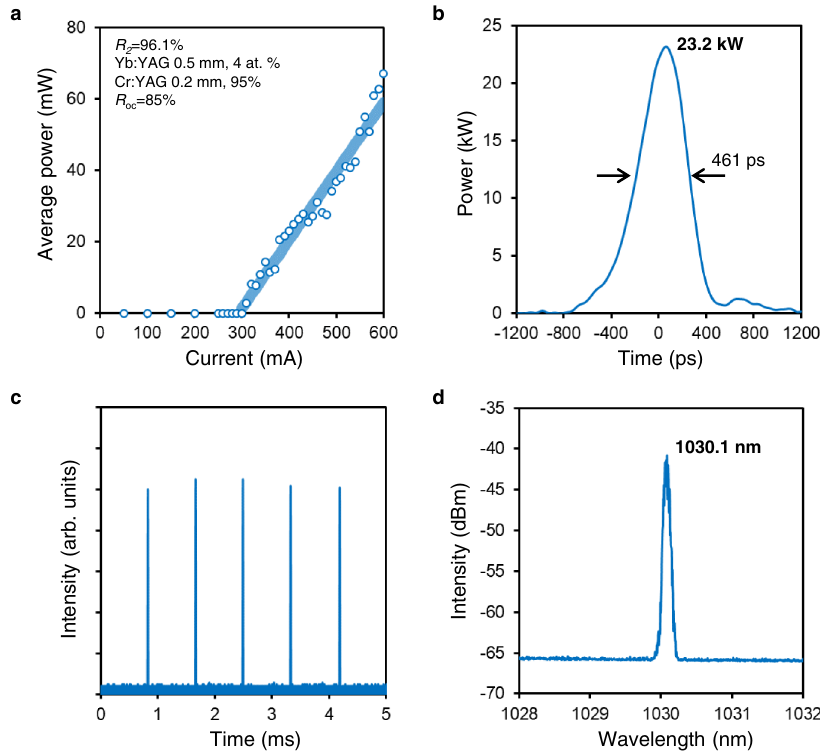
Fig. 4 | Experimental results of the mechanically assembled laser. a I – L char- acteristics. b Single-pulse waveform. The vertical axis was calculated from the obtained pulse energy (12.1 μ J) and the pulse waveform. c Temporal waveform.